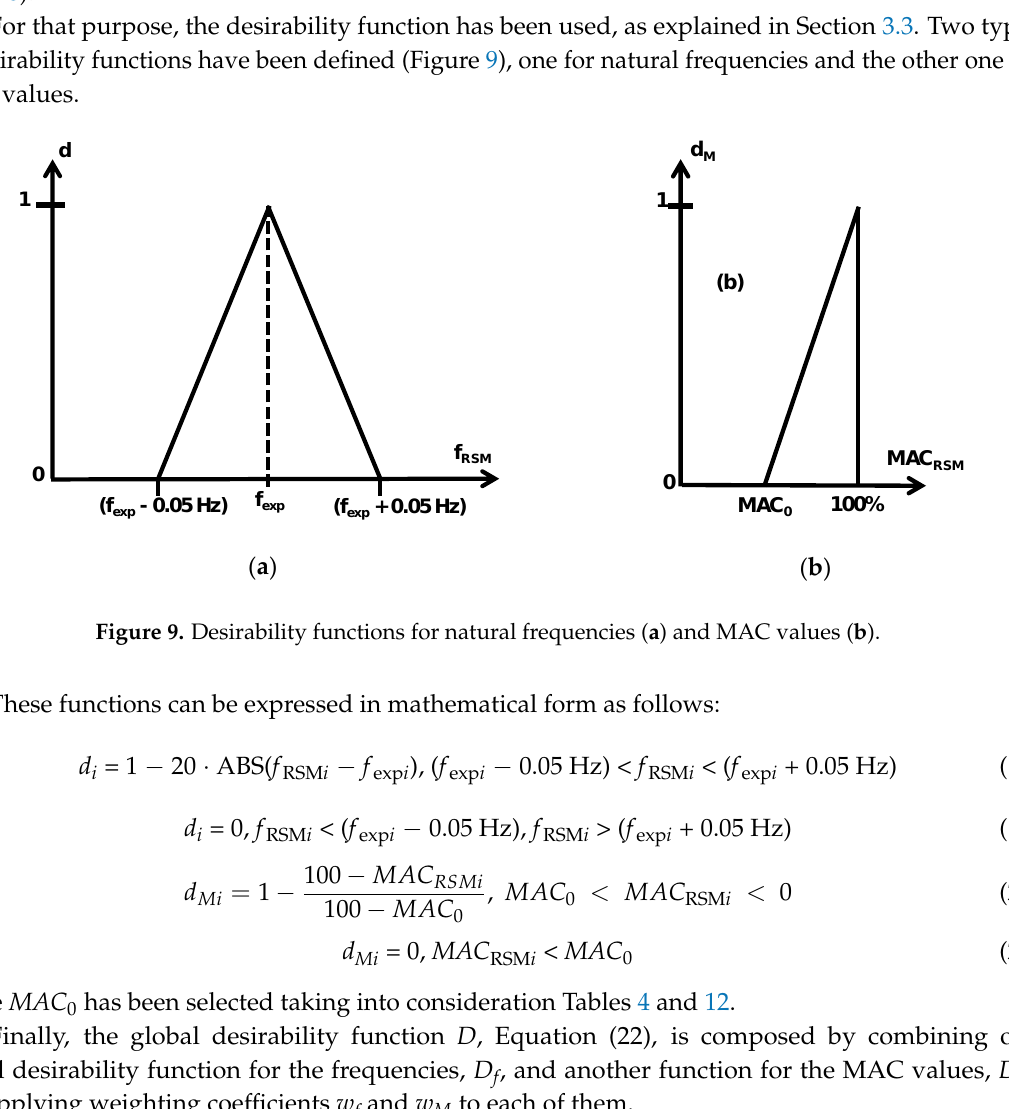
Table 13. Updated values of the design variables. Units of k i are N/µm.